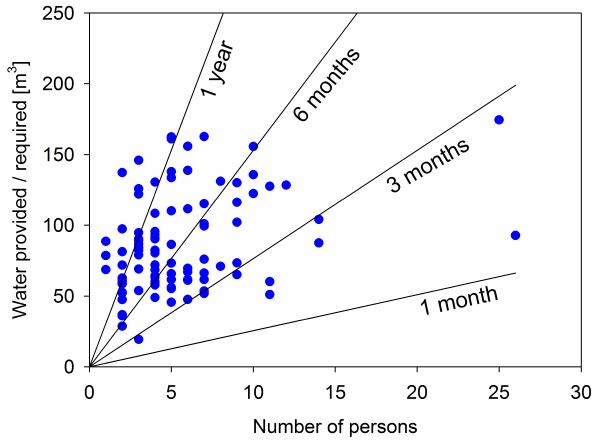
Fig. 10. Number of persons and amount of RWH supplied for 79 households with active cisterns in Ramallah; lines illustrate re- quired drinking water assuming a per capita water consumption of 85lday − 1 (Magiera et al.,